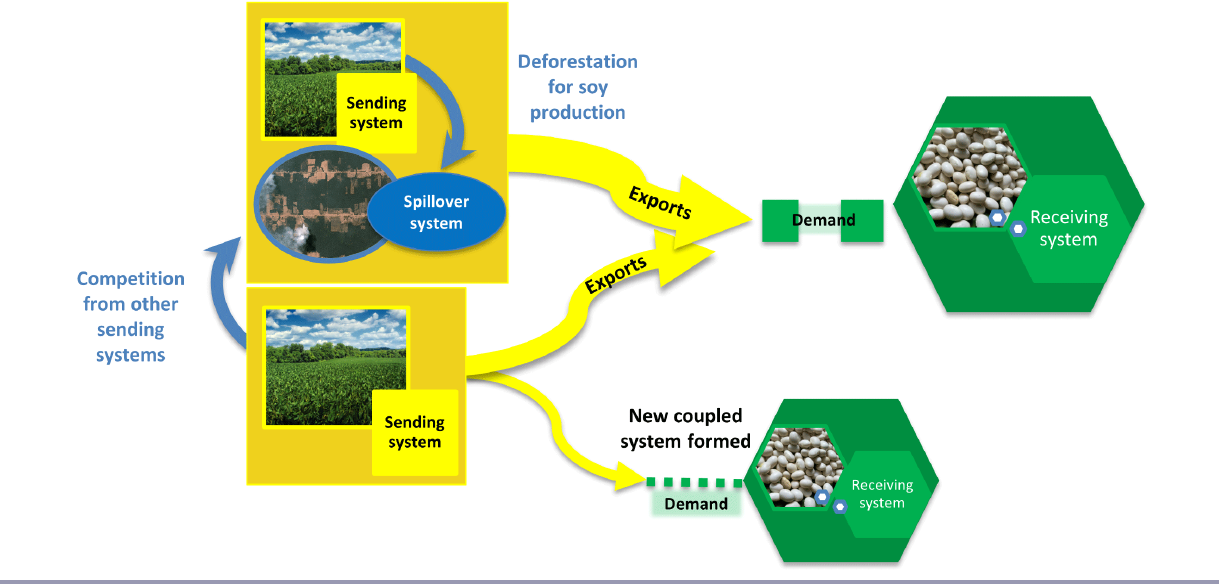
Fig. 1 . The soybean metacoupled system, including sending systems (yellow), receiving systems (green), and spillover systems (blue), with arrows showing the connections that occur within and between